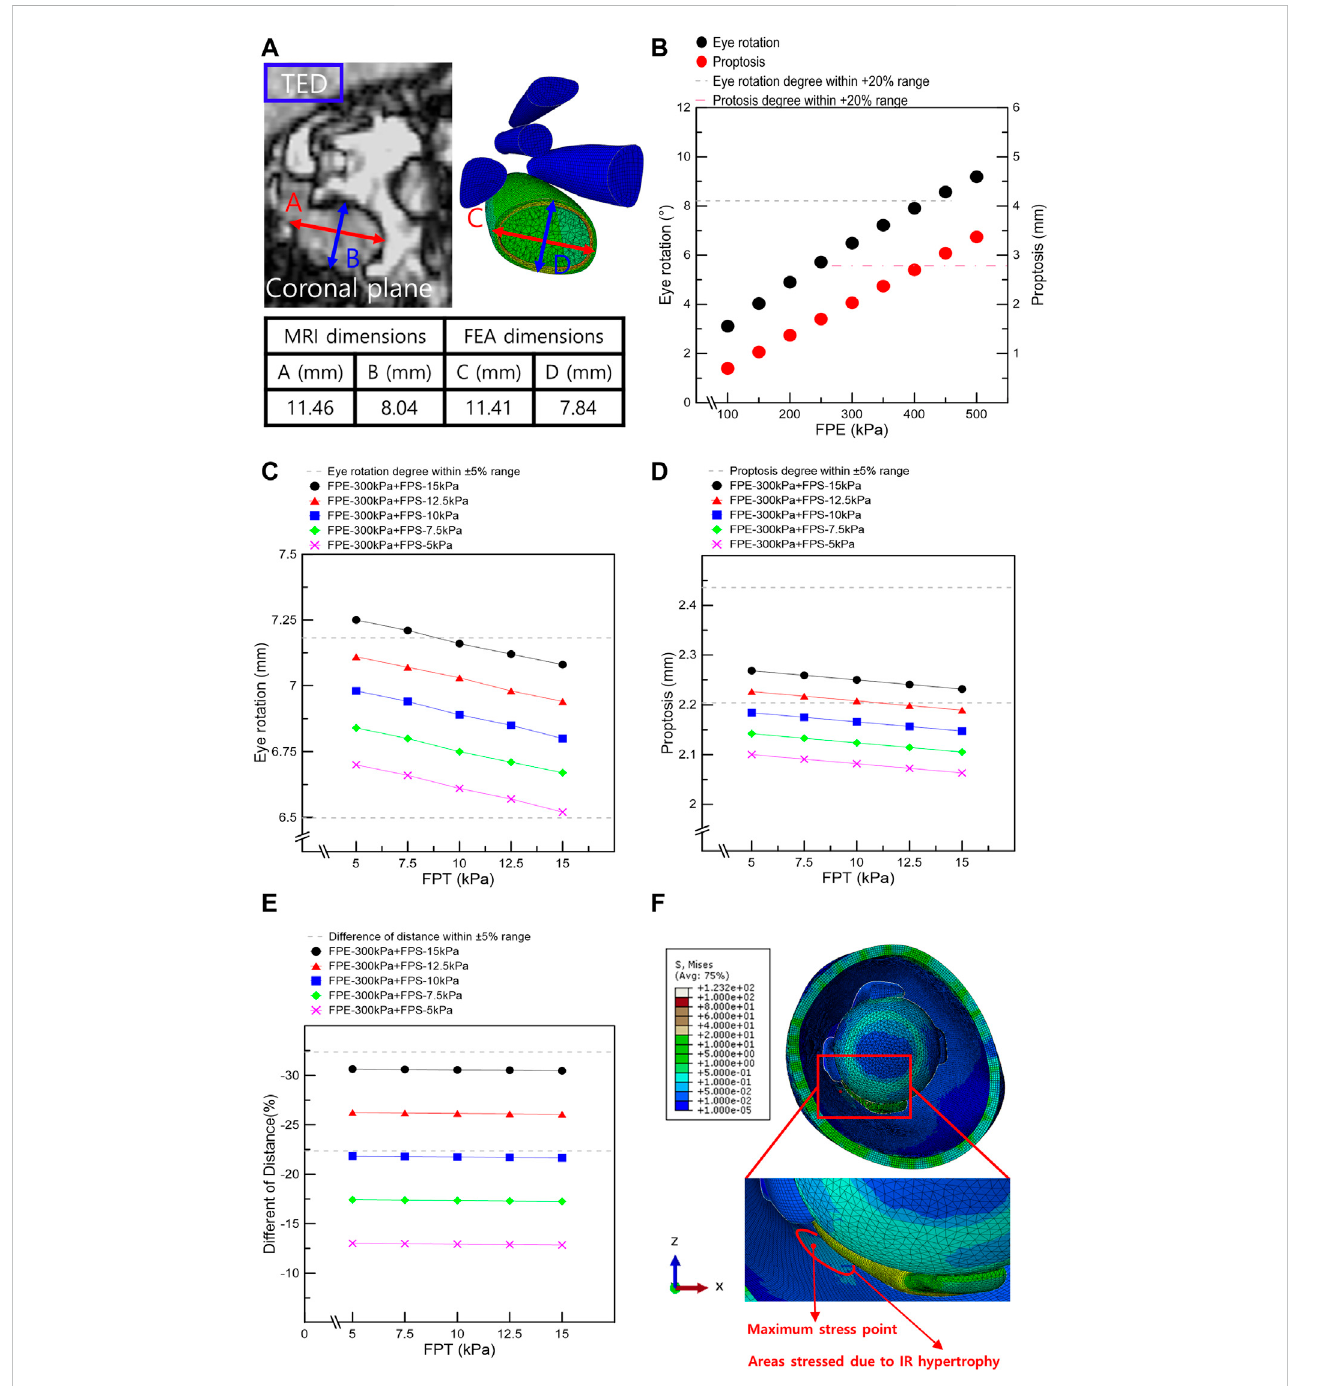
Results from fi nite element analysis of IR muscle hypertrophy and elevated IOP. (A) Thickness and width of IR in MRI image and fi nite element analysis of IR muscle hypertrophy. (B) Eye rotation and proptosis according to the load conditions of FPE. (C) Eye rotation responses according to the load conditions of fat pressure toward the skin eyeball (FPE), skin (FPS), and tissue (FPT). (D) Proptosis according to the load conditions of FPE, FPS, and FPT. (E) Distances between the ocular and skin endpoints according to the load conditions of FPE, FPS, and FPT. (F) Maximum stress point in FEA of IR hypertrophy and elevated